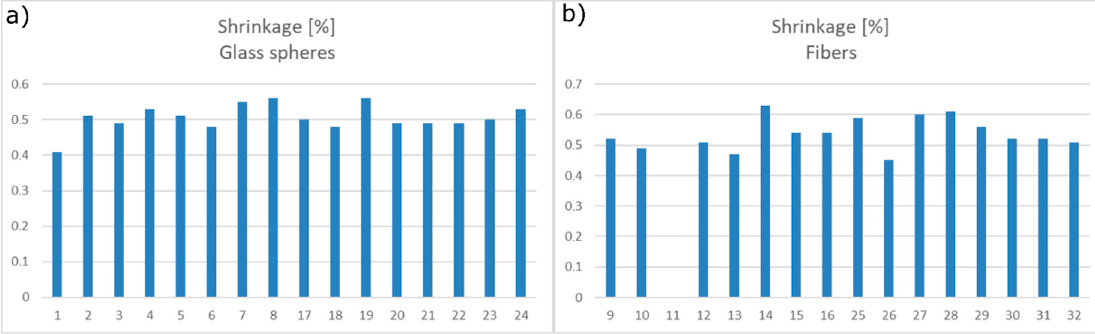
Figure 7. Shrinkage measurement of length and width in comparison to the original dimensions. ( a ) Measurements of shrinkage of glass sphere filled material with a standard deviation of 0.036%. ( b ) Measurements of shrinkage of fiber filled material with a standard deviation of 0.05%.